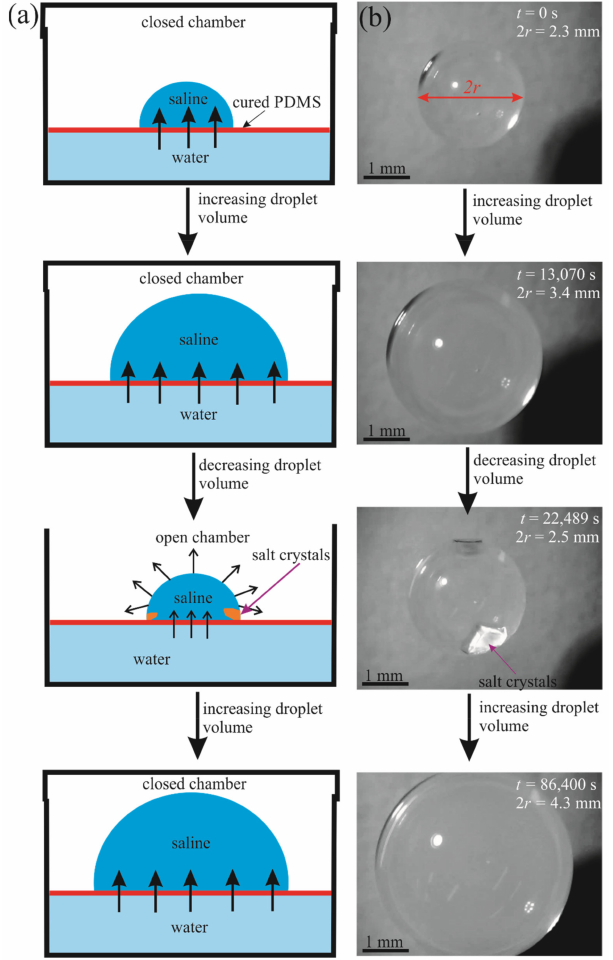
Figure 2. Growth and decay of a 5 µ L saline droplet on a floating PDMS membrane due to osmosis and evaporation; ( a ) schematic and ( b )